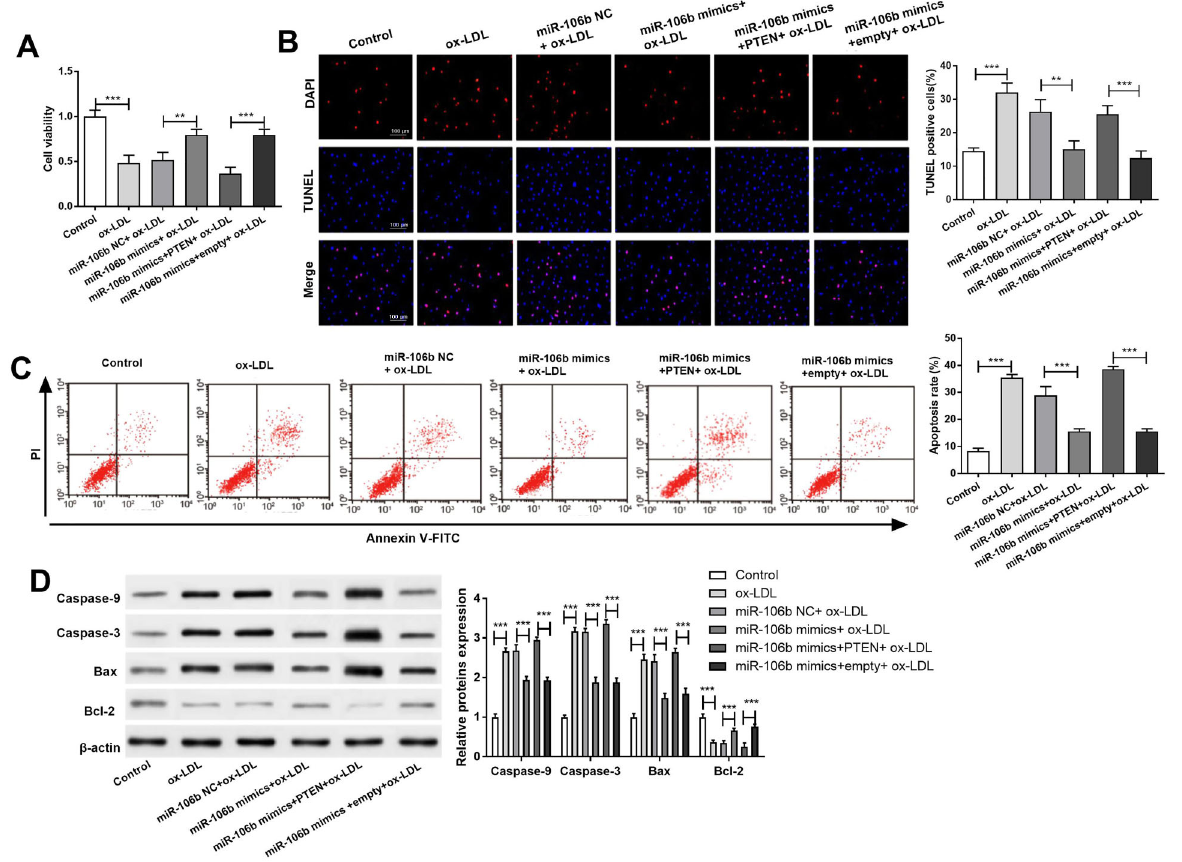
Figure 4. Overexpression of PTEN inhibited the anti-apoptotic effect of miR-106b. A , Proliferation of human aortic endothelial cells. B , Number of activity cells by TUNEL assay ( (cid:1) 400, scale bar 100 m m). C , Apoptosis of human aortic endothelial cells. D , Expression of caspase-3, caspase-9, Bax, and Bcl-2 protein. Data are reported as means ± SD. **P o 0.01, ***P o 0.001 (ANOVA). ox-LDL: oxidized- low-density lipoproteins; NC: negative